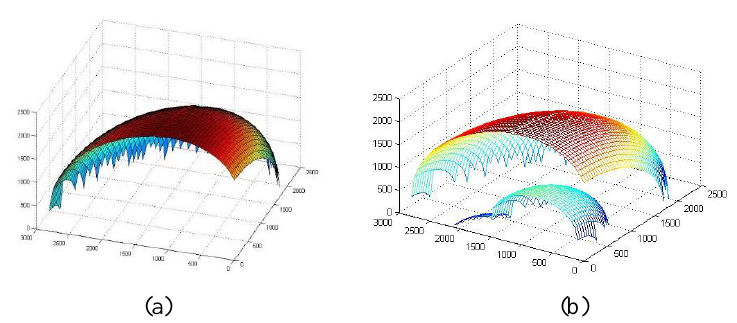
Fig. 10. The workspace of the robot (rotated): (a) the far boundary; (b) far and near the border.